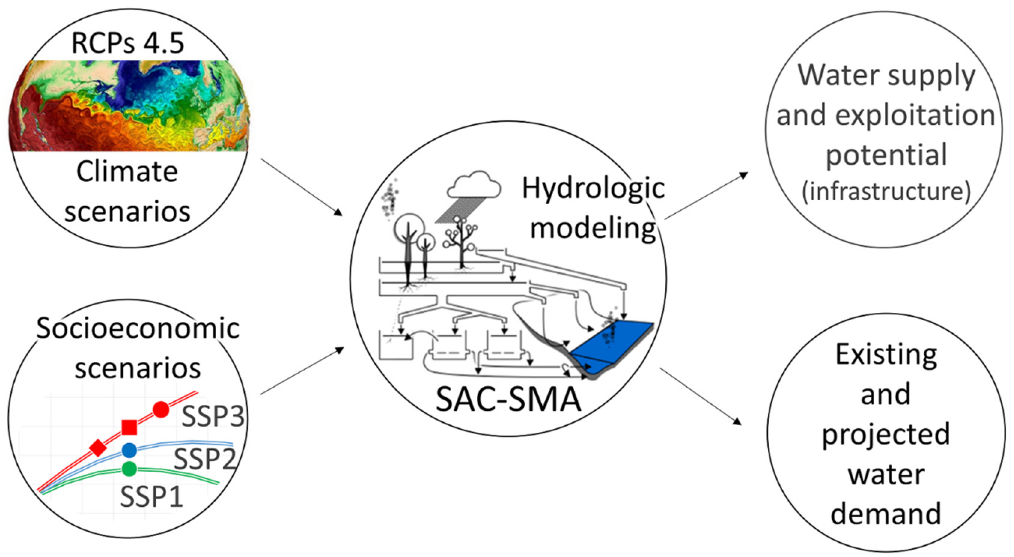
Figure B3. Framework for assessing the water resources balance of the Messara study site, adopted by Koutroulis et al.